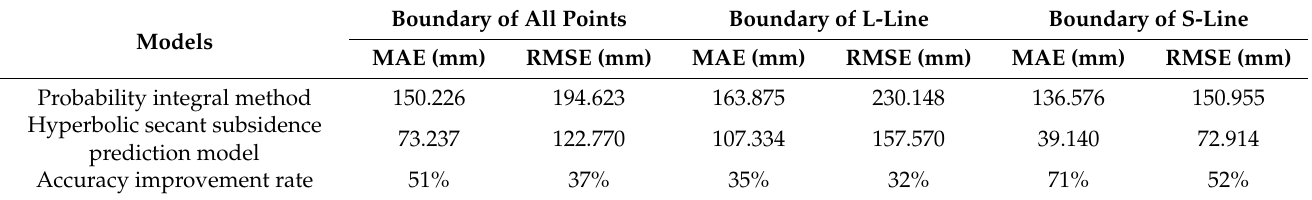
Table 3. Model prediction